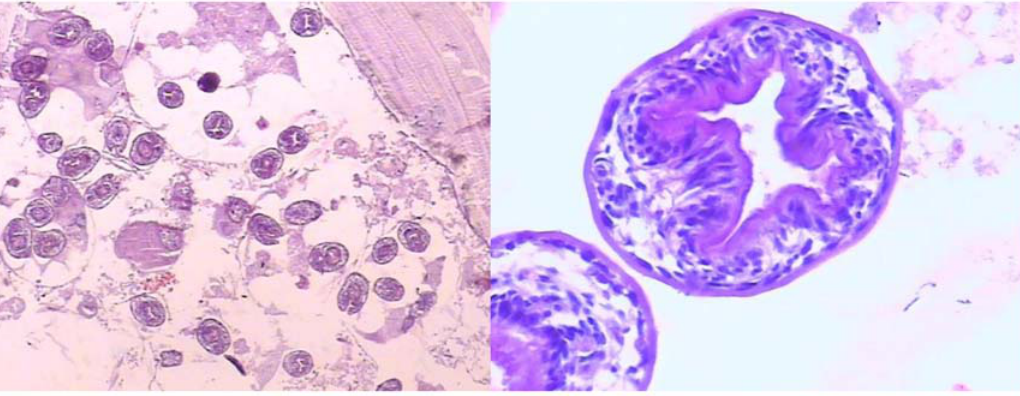
Figure 2. Histopathologic section (haematoxylin and eosin stain) of the liver lesion from a ground squirrel ( Spermophilusdauricus/ alashanicus ). Left panel shows the typical appearance of a fertile Echinococcus granulosus cyst with laminated and germinal layers, brood capsules and numerous viable protoscoleces; right panel is an enlarged part of the section showing two viable protoscoleces ( 6 1000).